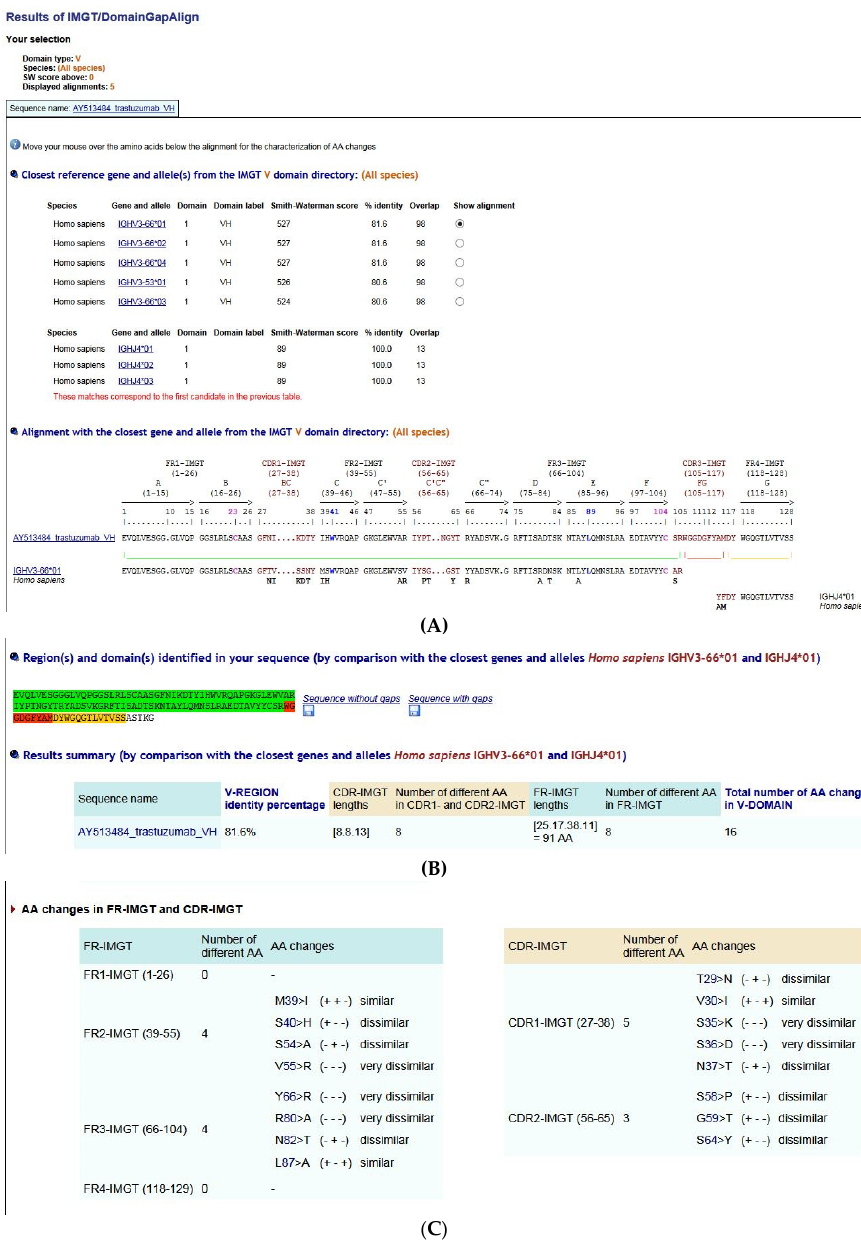
Figure 29. IMGT/DomainGapAlign [58,79,80]. ( A ). Analysis of the translated AY513484 sequence (trastuzumab VH). The analysis at the amino acid level gives the same percent of identity and same score for three alleles of IGHV3 ‐ 66*02 (the one identified by nucleotide analysis, as well as *01 and *04. Analysis at the amino acid level gives IGHJ4*01 as the closest IGHJ gene and allele, mentioned in the IMGT/V ‐ QUEST comments (in red in Figure 26A). The results are presented according to the IMGT Protein display header for V ‐ DOMAIN [41]. ( B ). Regions and domains identified by IMGT / DomainGapAlign in the trastuzumab VH (V-REGION in green, N-AND-D-REGION in red and J-REGION in orange) and Results summary (by comparison with the closest genes and alleles IGHV3-66*01 and IGHJ4*01). Results summary comprises the V-REGION identity percentage (81.6%), CDR-IMGT lengths [8.8.13], Number of di ff erent AA changes in CDR1-IMGT and CDR2-IMGT, FR-IMGT lengths, Number of di ff erent AA in FR-IMGT and Total number of AA change in V-DOMAIN. ( C ). AA changes in FR-IMGT and CDR-IMGT with similarity characteristics. (With permission from M-P. Lefranc and G. Lefranc, LIGM, Founders and Authors of IMGT ® , the international ImMunoGeneTics information system ® , http: //